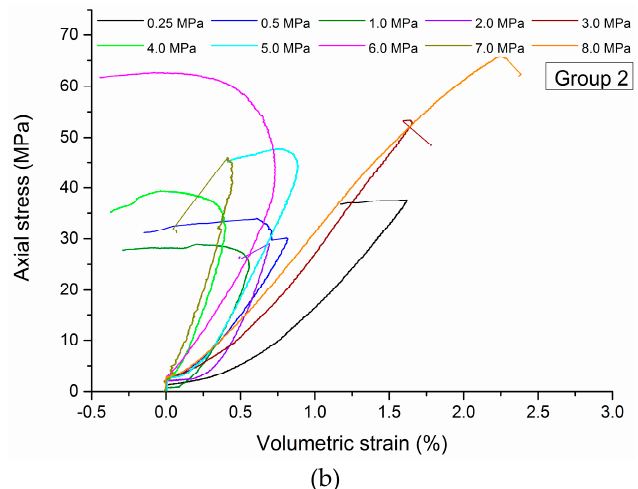
Figure 7. Axial stress and volumetric strain behavior of coal specimens under different confining stresses: ( a ) group 1; ( b ) group 2.